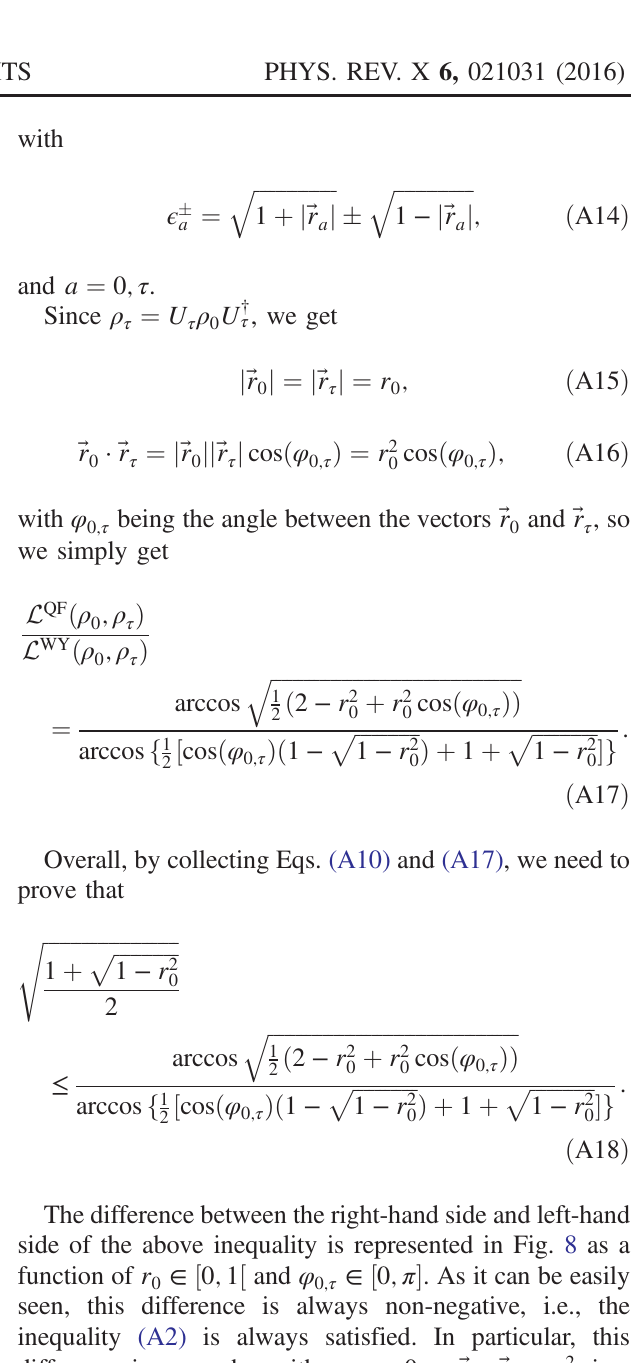
ffiffiffiffiffiffiffiffiffiffiffiffi p 1 − r 2